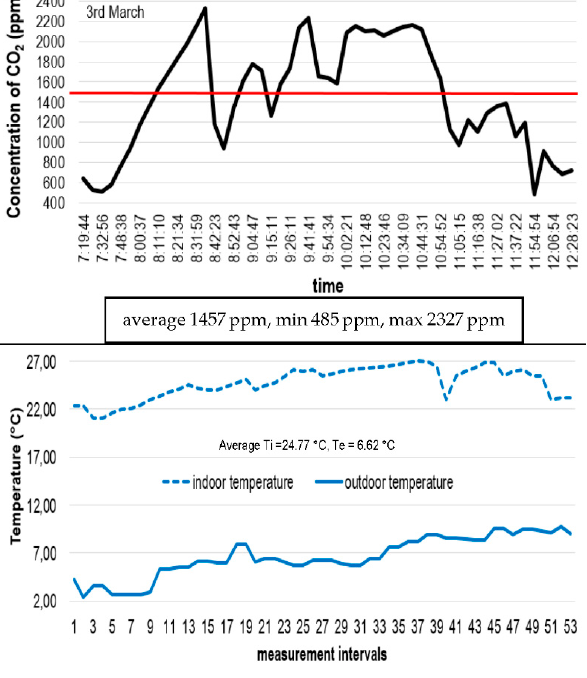
Figure 7. Daily profiles of CO 2 concentration and indoor/outdoor temperatures (3rd March).